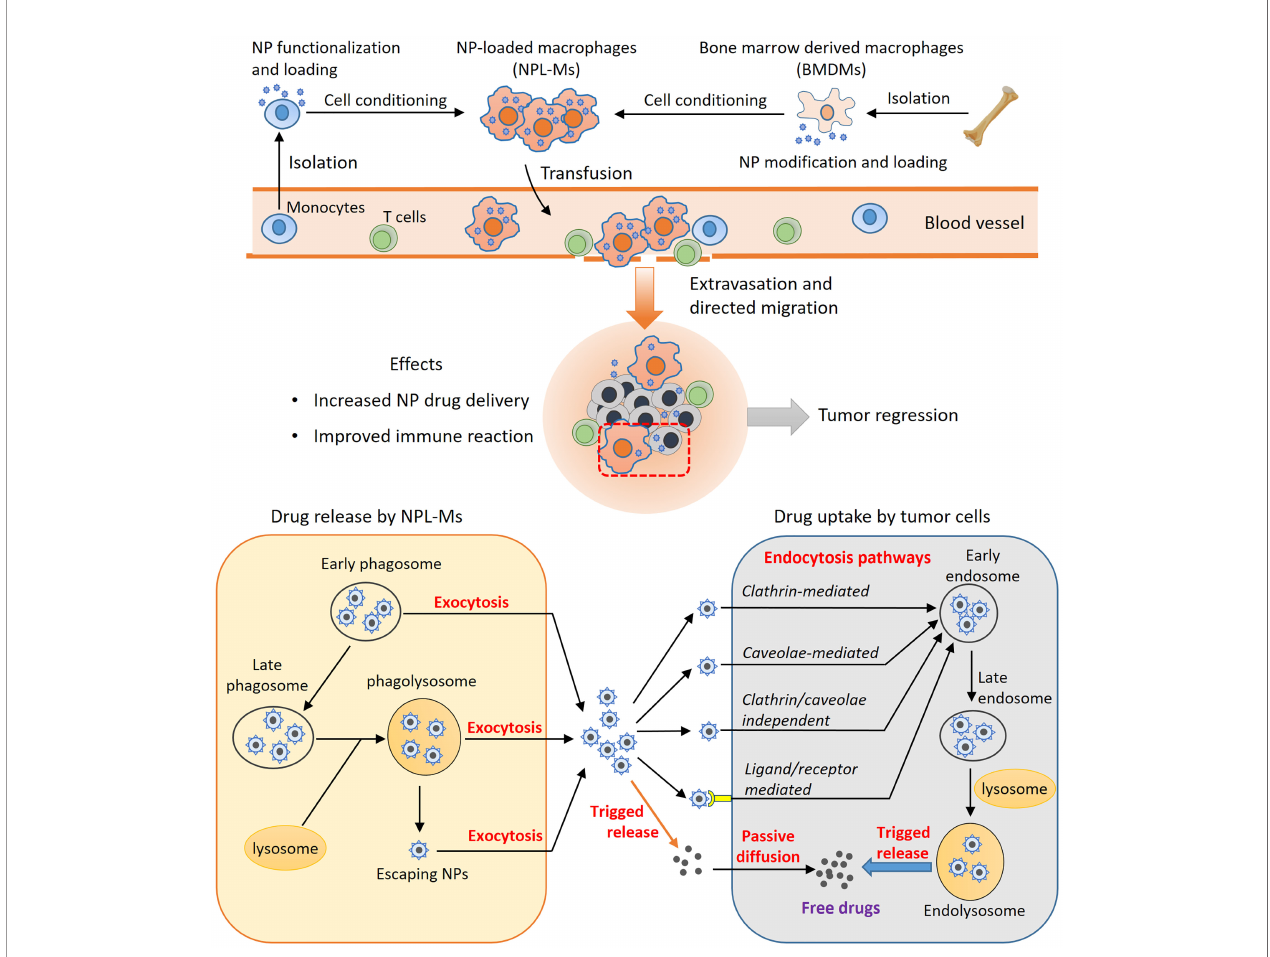
FIGURE 2 | The principles of macrophage-based NP drug delivery. Live macrophage carriers are mainly from peripheral monocytes, bone marrow-derived macrophages, or macrophage cell lines. M1-type macrophage differentiation can be induced, and NPs can be functionalized. After administration, the NPL-Ms migrate to tumors, enhancing drug delivery and anticancer immune responses. The ef fi ciency of this strategy depends on controlled drug release by NPL-Ms and effective drug uptake by neighboring tumor cells. Through exocytosis, NPs recycled from early phagosomes or matured phagolysosomes or NPs that escape from phagosomes can be released through the exocytosis mechanism. Tumor cells uptake NPs through various endocytosis pathways, such as the clathrin-mediated, caveolae-mediated, and clathrin/caveolae-independent pathways. NPs functionalized by surface ligands can be recognized by corresponding receptors on tumor cells and effectively internalized by endocytosis. Consequently, the internalized NPs are sorted into early endosomes, late endosomes, and eventually endolysosomes where NPs can be triggered to release free drugs. Free drugs released from NPs in the intracellular space can enter into tumor cells by passive